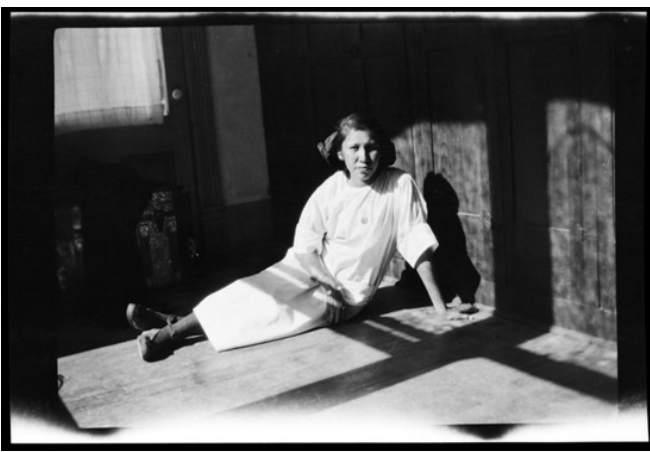
Figure 16. Lucy Sumpty, Inside the Girls’ Dormitory—Phoenix Indian Boarding School, c. 1915. Parker McKenzie Collection. Courtesy of the Oklahoma Historical Society.